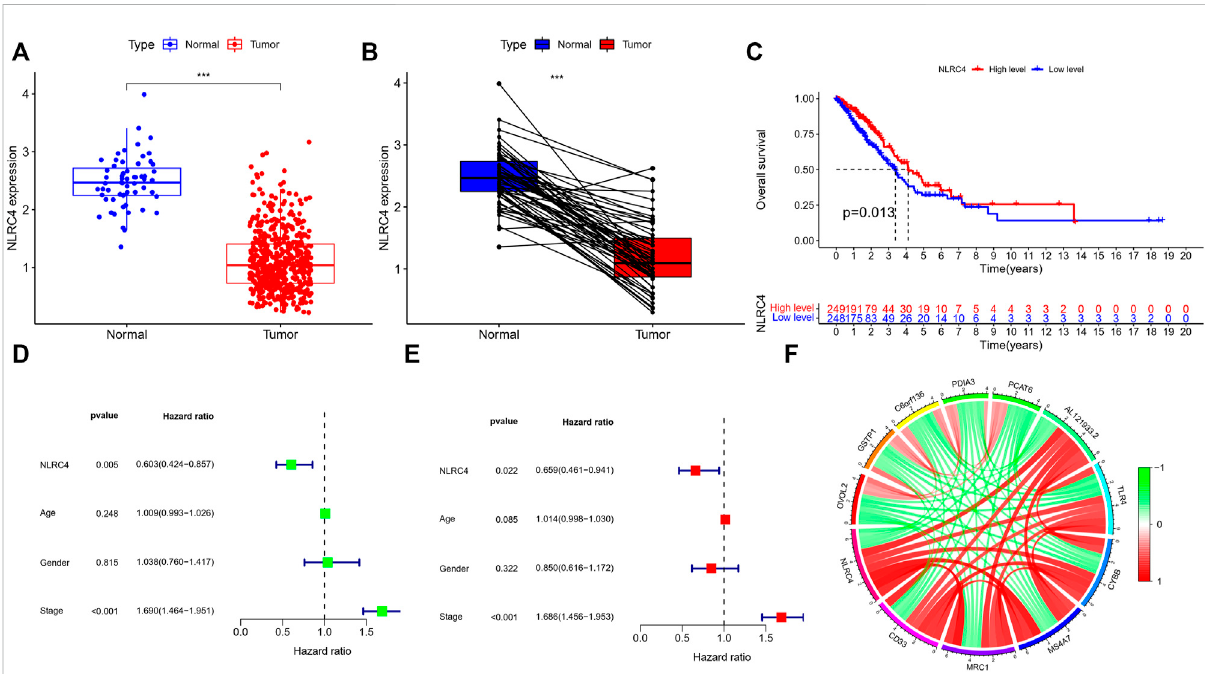
FIGURE 11 (A,B) Expression of NLRC4 in TCGA cohort compared with normal samples (wilcox test, *** p < 0.001). (C) K-M survival analyses based on the expression of NLRC4 in the LUAD-TCGA cohort. (Chi-squared test) (D,E) Univariate and multivariate analyses of different parameters related to survival. (F) The correlation of NLRC4 with other genes (red line: positive correlation; green line: negative